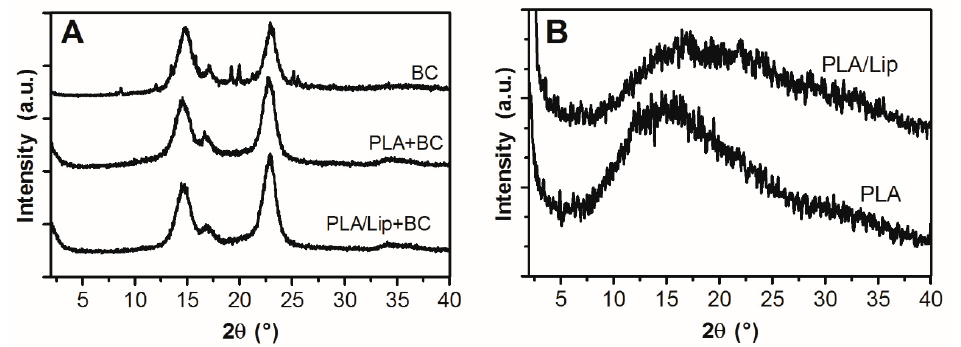
Figure 4. X-ray diffractograms of BC, BC/PLA, and BC/PLA/Lip nanocomposites ( A ), and electrospun PLA with and without lipids ( B ). PLA with and without lipids ( B